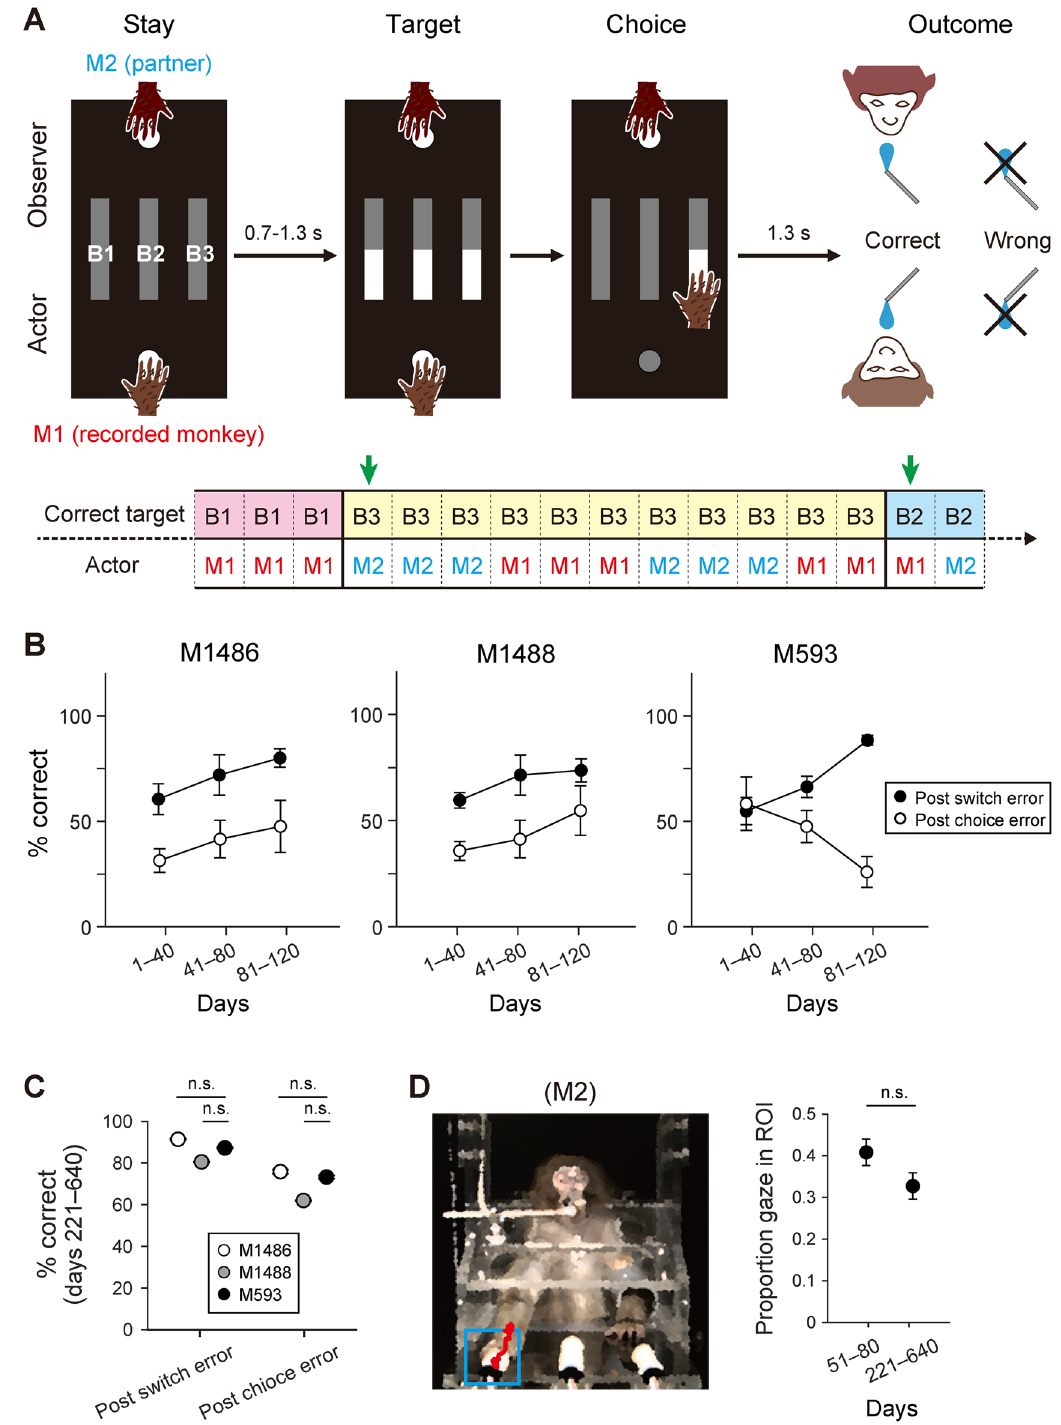
Figure 2. Behavioral procedures in social task condition for M593. ( A ) Sequence of events in social reversal learning task. M1, recorded monkey or self; M2, partner. The correct target was switched after every 11–17 trials without prior notice. Green arrows indicate switch trials. The actor role was alternated between M1 and M2 after every three trials. Reward feedback was presented to both monkeys simultaneously. ( B ) Time courses of performance accuracy in trials immediately after partner’s switch and choice errors. Mean ± SEM. Note the progressive divergence of performance in M593. ( C ) Performance accuracy at later learning stages (days 221–640). Mean ± SEM; n.s., not significant (two-tailed Welch’s t -test). ( D ) Gaze behavior. Left , blue rectangle indicates the target ROI when B1 was correct, and red dots indicate M1’s gaze direction. Right , proportions of gaze at the target ROI in earlier and later training days. Mean ± SEM; n.s., not significant (two-tailed Welch’s t